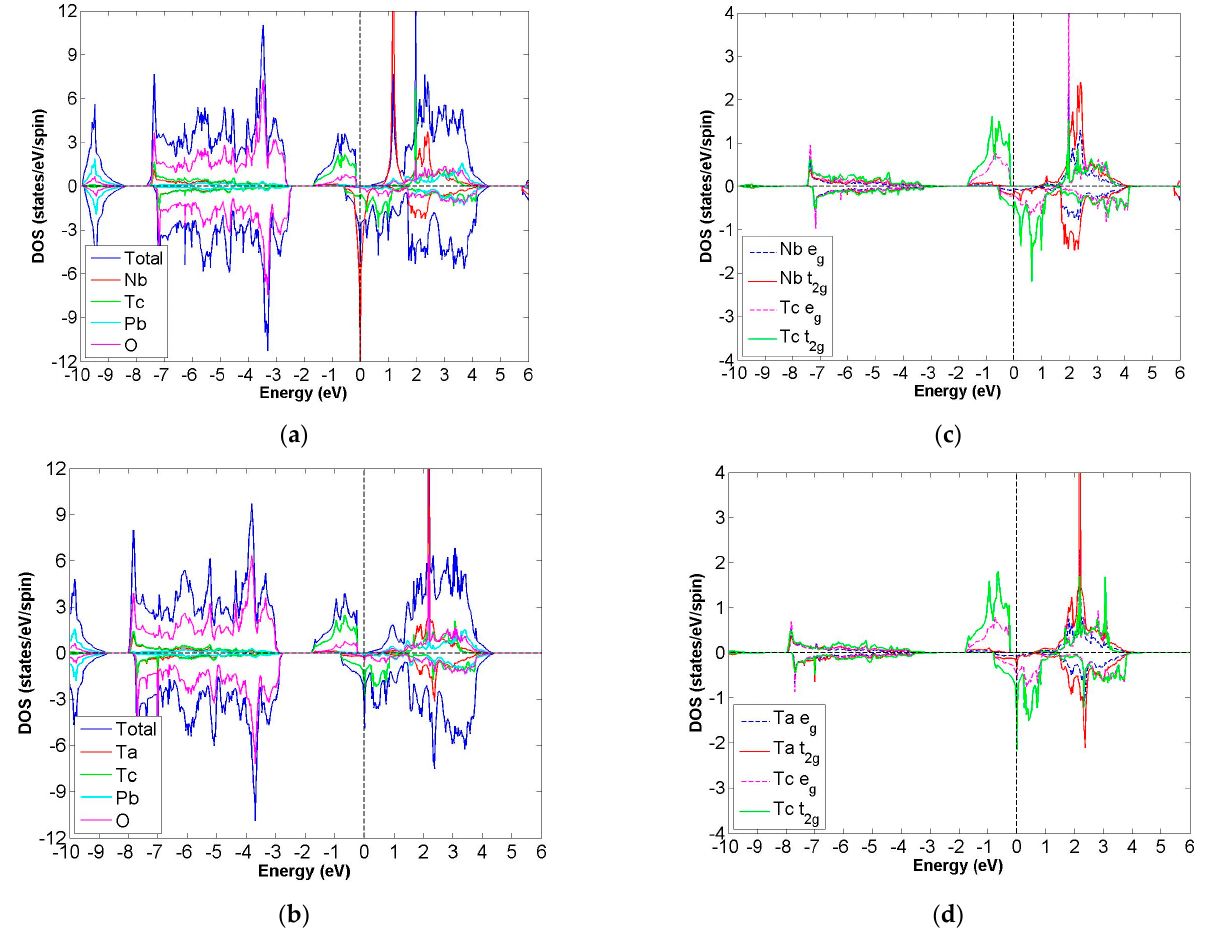
Figure 3. Based on the GGA calculation, the calculated total and partial DOS values of ( a ) Pb 2 NbTcO 6 and ( b ) Pb 2 TaTcO 6 and the partial DOS of e g and t 2g spin orbitals for ( c ) Nb and Tc and ( d ) Ta and Tc.